Question: Does the plotted quantity increase or decrease?
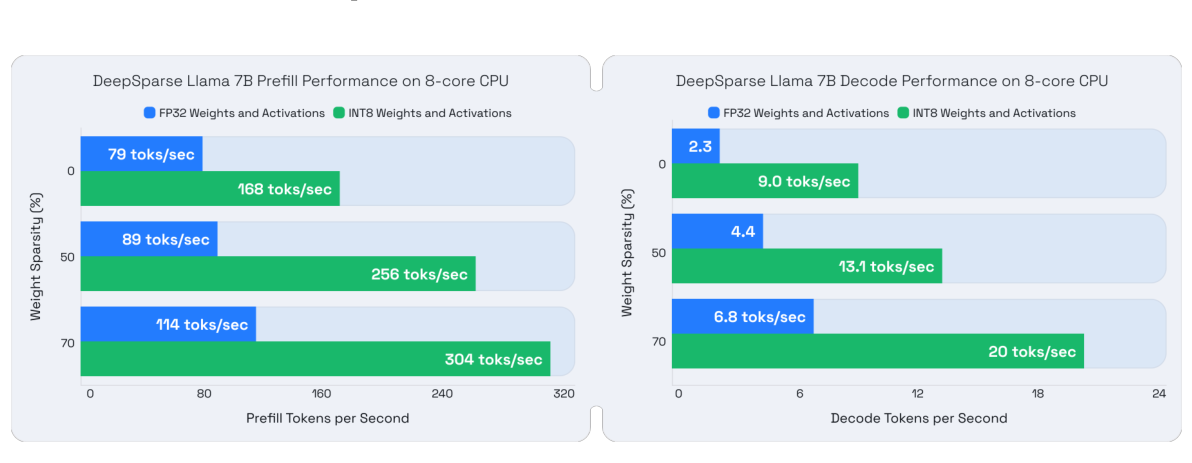
Answer: increasing